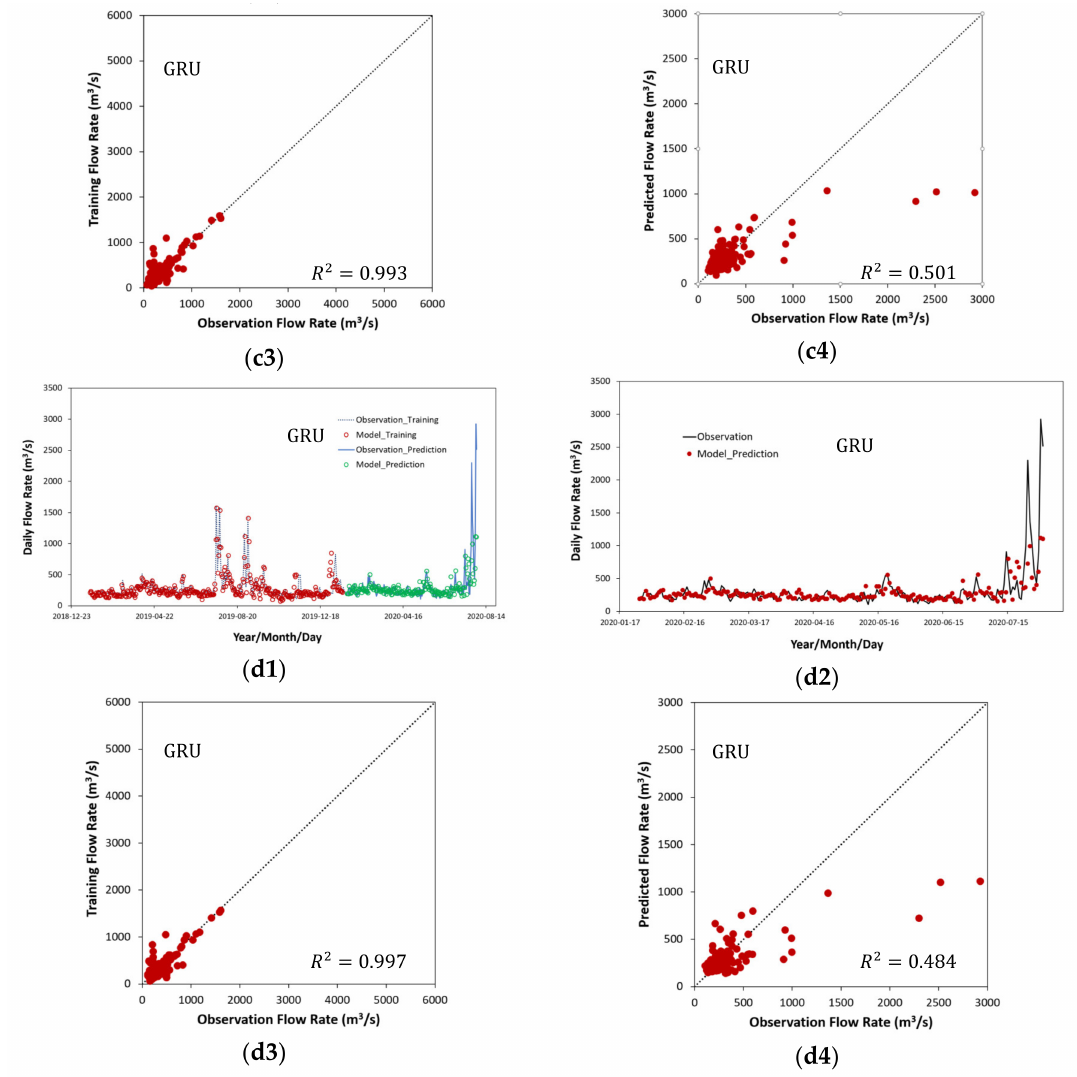
Figure 10. GRU performance with changes in length of training data and prediction data: ( a1 )–( d1 ) flow rates for training; ( a2 )–( d2 ) flow rates for prediction; ( a3 )–( d3 ) R 2 for training; ( a4 )–( d4 ) R 2 for prediction; ( a1 )–( a4 ) ratio of 80 to 20; ( b1 )–( b4 ) ratio of 74.9 to 25.1; ( c1 )–( c4 ) ratio of 71.4 to 28.6; ( d1 )–( d4 ) ratio of 66.8 to